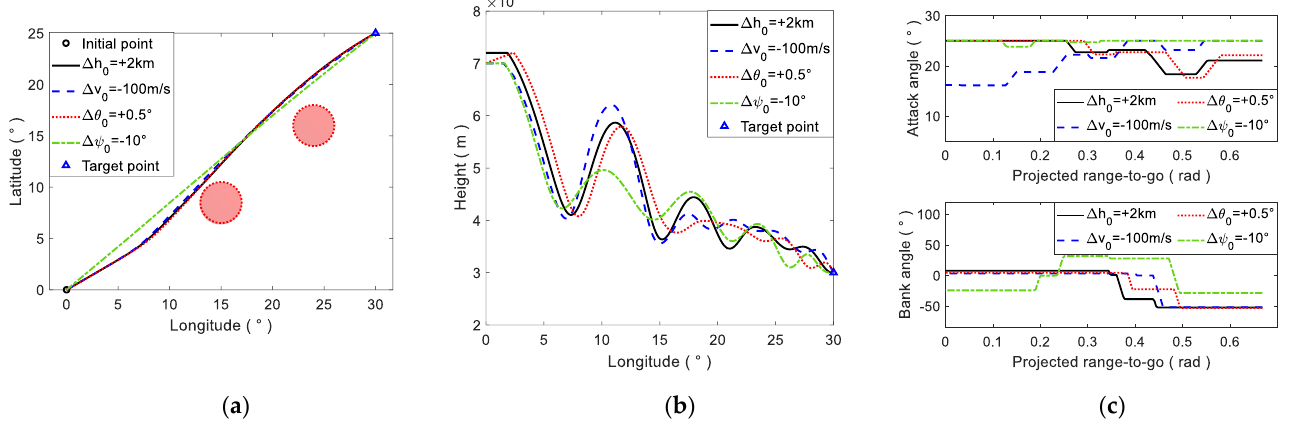
( c ) Figure 9. The generation effects of different target points: ( a ) represents the lateral trajectories; ( b ) represents the longitudinal trajectories; ( c ) represents the control angles. 5.5. Simulation Experiment with Initial State Disturbance